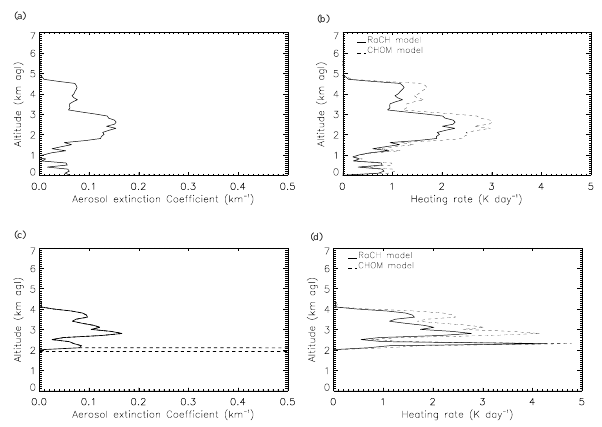
Fig.7. LEANDRE-derivedAECprofilesat10 ◦ N (a) incloud-freeconditionsand5 ◦ N (c) incloudyconditions,andcorrespondingheating rate(HR) (b,d) forthe14June.Dashedlinein(c)correspondstolocationofthecloudtopasderivedfromLEANDRE2measurements.